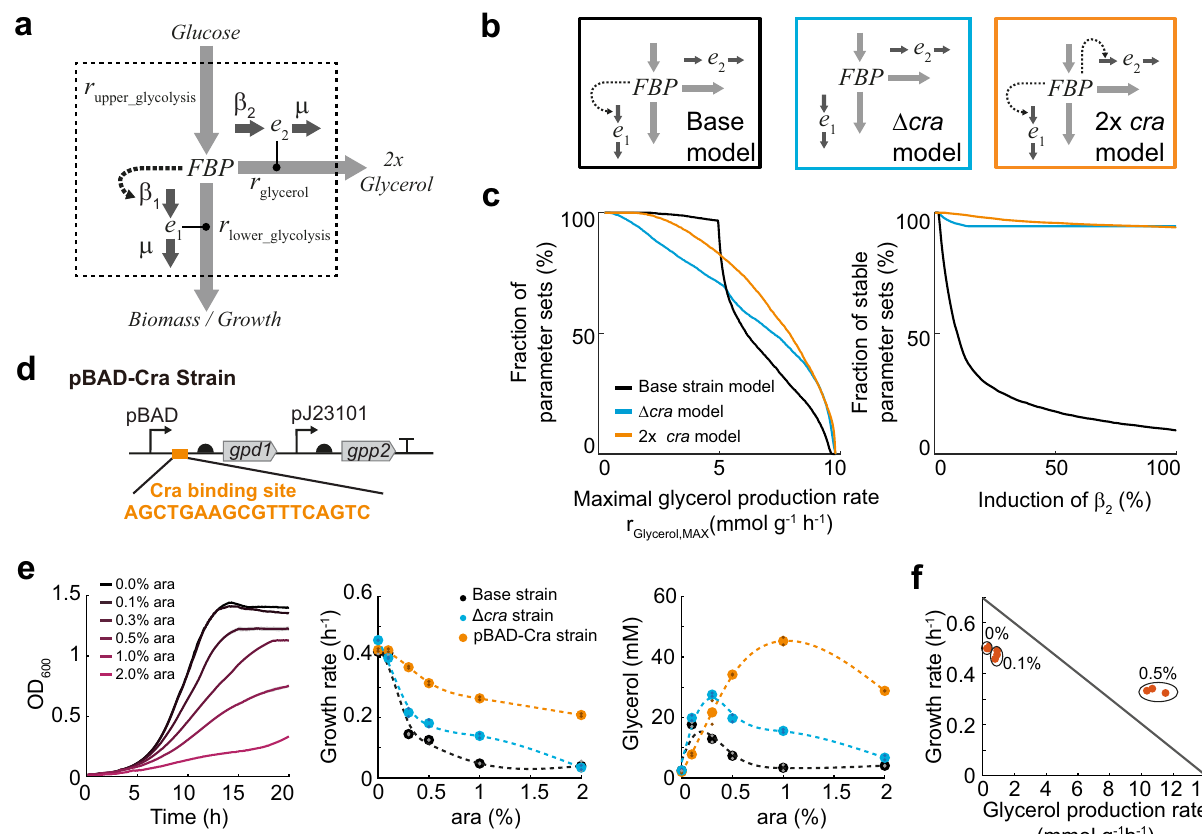
Fig. 3 Theoretical and experimental analysis of glycerol production with a Cra-regulated pBAD promoter. a Stoichiometry and structure of the kinetic model. The dashed box is the model boundary. FBP is a metabolite in glycolysis, and e1 and e2 are enzymes. Solid, gray arrows are metabolic reactions. The input reaction in upper glycolysis is fi xed to 4.9 mmolg − 1 h − 1 . The reaction in lower glycolysis and the glycerol pathway depends on FBP levels and enzyme levels, according to Michaelis – Menten kinetics. The dashed arrow is FBP-activation of β 1 (the expression rate of e1) and represents the net effect of Cra regulation: FBP inhibits Cra; Cra inhibits β 1 . Gradual increases of β 2 (the expression rate of e2) simulate induction with arabinose. b A model of the base strain (black), a model of the Δ cra strain (blue), and a model with additional Cra regulation of e2 expression (orange). c The three models in b were simulated with the same 5000 parameter sets that were obtained by random sampling (see also Table 1). For each parameter set, β 2 (the expression rate of e2) was increased until the model became unstable or until the expression rate β 2 reached the maximum. Shown is the maximal glycerol fl ux that was achieved with each model as a cumulative sum distribution. Robustness is shown as the percentage of the 5000 models that remain stable at a given induction level. d The pBAD promoter was engineered by inserting a Cra-binding site between the promoter and the ribosome-binding site, resulting in the pBAD-Cra promoter. Cra-FBP regulation should ensure that low FBP levels repress the pBAD-Cra promoter. The pBAD promoter in the base strain (Fig. 1a) was replaced with the pBAD-Cra promoter, resulting in the pBAD-Cra strain. e The pBAD-Cra strain (orange) was cultured in 96-well plates. Growth was measured in a plate reader at different induction levels of GPD1 (0, 0.1, 0.3, 0.5, 1, and 2% ara). Glycerol in the medium was measured after 24 h. Growth rates were determined by regression analysis between 5 and 10 h. Small dots show data from n = 2 plate reader cultures and big dots are the mean. Data of the base strain (black) and the Δ cra strain (blue) are shown as a reference (same data as in Figs. 1d and 2e). f Growth rates and glycerol production rates of the pBAD-Cra strain measured in shake fl asks, at 0, 0.1, and 0.5% ara. The line is the theoretical relationship between glycerol fl ux and growth rate shown in Fig. 1e. Source data are provided in the Source Data fi